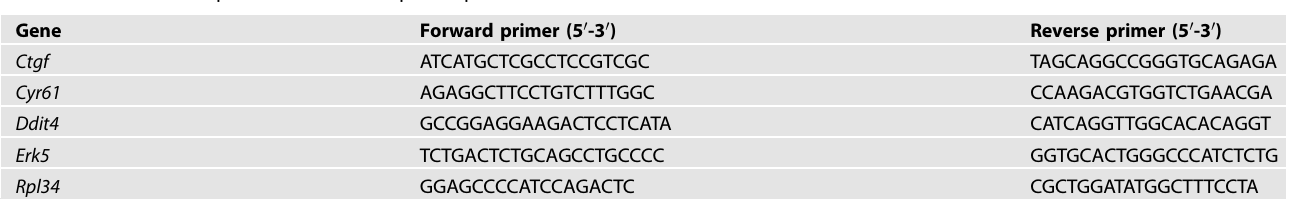
Fig. 7 ERK5 inhibition interferes with YAP-dependent migration and gene expression of liver cancer cells in a LATS-independent manner. A Wound healing assay of YAP5SA-expressing HuH7 cells and control cells treated with 10 µM BIX02189 or DMSO for 16 h (T16). The images are representative of two independent experiments performed in duplicate. Cell migration was manually quanti fi ed as average distance between the edges of the gap (gap width). B RT-qPCR analysis of the indicated YAP target genes in mutant YAP5SA-overexpressing HuH7 cells (YAP5SA) and in control cells (CTR), treated with 10 µM BIX02189 or DMSO. Data are expressed as relative gene expression and shown as mean ± S.E.M. of three independent experiments. Statistically signi fi cant differences are reported (* p < 0.05; ** p < 0.01; *** p < 0.001). Table 1. List of mouse primers used for RT-qPCR